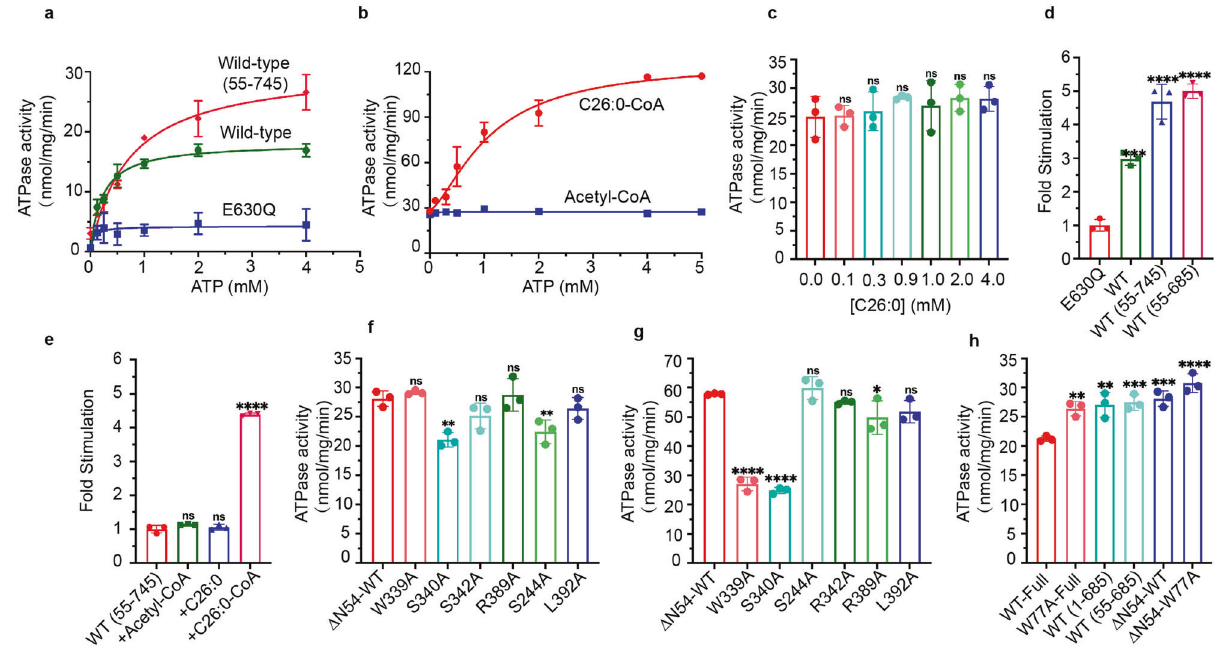
Fig. 1 ATPase activity of human ABCD1 stimulated by substrates. a ATPase activity of the full-length wild-type, E630Q mutant, and the N-terminal truncated proteins puri fi ed in GDN. The full-length wild-type protein showed a K M of 279 ± 18 µM for ATP and a maximal hydrolysis activity of 18 nmol/mg/min. b ATPase activity of the truncation mutant devoid of N-terminal 54 residues in the presence of Acyl-CoA at different concentrations. c ATPase activity of the truncation mutant devoid of N-terminal 54 residues in the presence of different concentrations of C26:0. d Normalized ATPase activity of E630Q mutant protein. The activity of the full-length wild-type protein, truncation mutant devoid of N-terminal 54 residues, and truncation mutant devoid of N-terminal 54 residues and C-terminal 60 residues was simulated. Maximal hydrolysis activity was selected to calculate the stimulated fold. e Stimulated ATPase activity of the truncation mutant devoid of N-terminal 54 residues in the presence of C26:0, C26:0-CoA, and acetyl-CoA. The maximal hydrolysis activity was selected to calculate the stimulate fold. f ATPase activity of ABCD1 mutants, in which the residues locating in the substrate-binding sites were mutated to alanine. g ATPase activity of ABCD1 mutants in the presence of C26:0-CoA. h ATPase activity of ABCD1 truncation mutants. The reported errors represent standard deviation. ns no signi fi cance , ✱✱✱✱ P < 0.0001, ✱✱✱ P < 0.001, ✱✱ P < 0.01, and ✱ P <